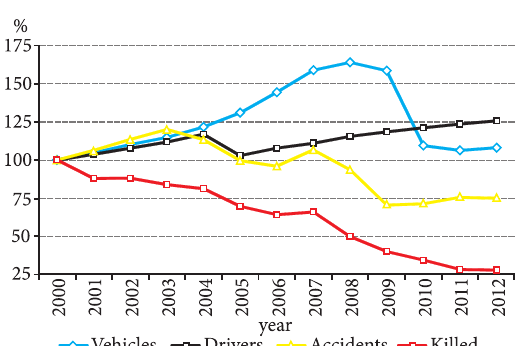
Table 1. Relative increase of number and mileage of vehicles permitted for traffic Year/year 2004/2005 2005/2006 2006/2007 2007/2008 2008/2009 2009/2010 2010/2011 2011/2012 Changes of the number of vehicles in good technical condition in comparison with the previous year, % Changes of vehicle mileage in comparison with the previous year, %